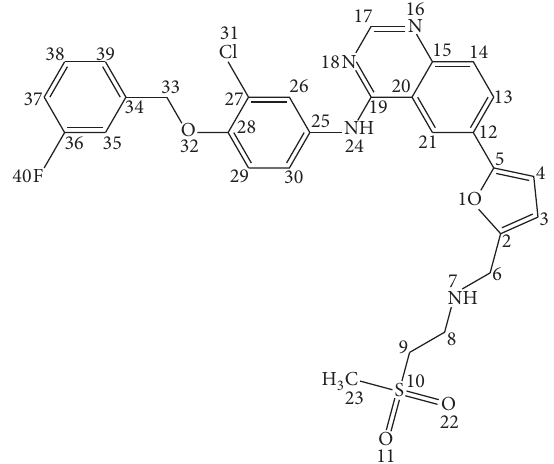
Figure 1: Chemical structure and numbering of